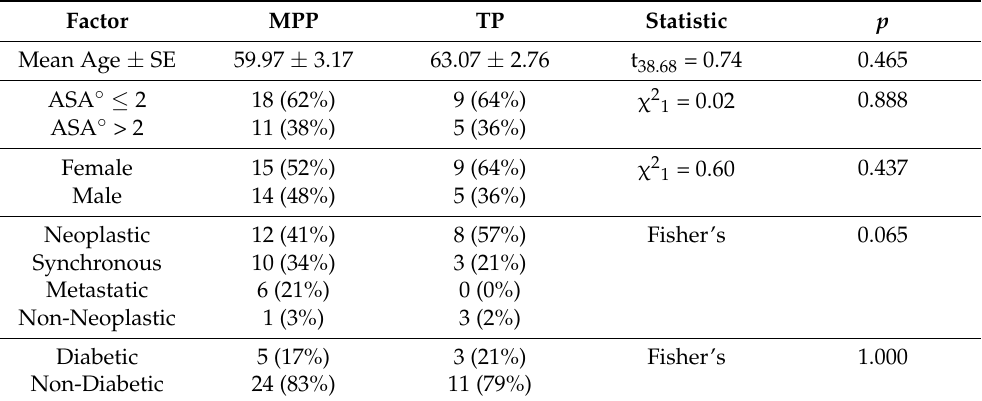
Table A2. Comparison of baseline variables between MPP and TP groups.